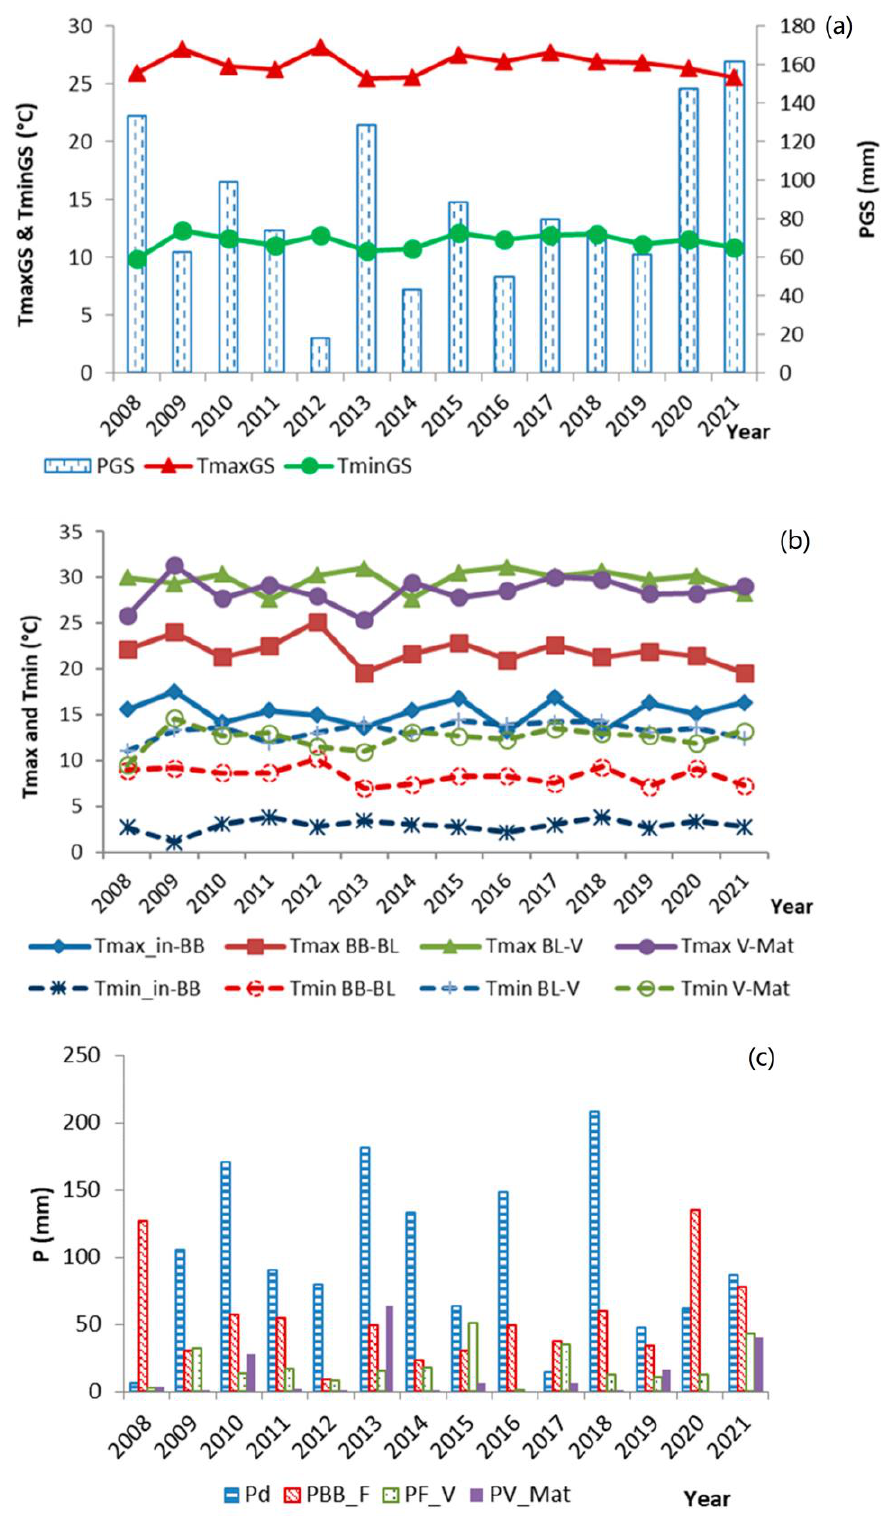
Figure 2. Variability in the climatic variables recorded in Rueda DO (Spain) during the period 2008–2021 (data from Rueda meteorological station). Average maximum (Tmax) and minimum (Tmin) temperatures and precipitation (P) for the growing season ( a ) and for different periods along the growing cycle ( b , c ). (GS. Growing season; d: period from 20 March to budbreak: BB-F: budbreak to flowering; F-V: flowering to v é raison; V-Mat: ripening